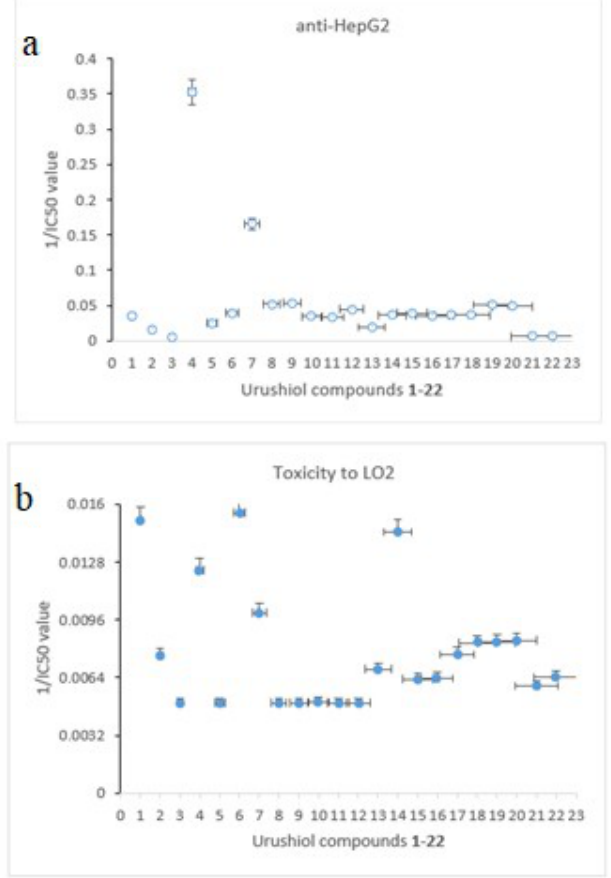
Figure 2. The relationship between compounds’ 1 – 22 anti-HepG2 or toxicity to LO2 and 1/IC50 value ( p < 0.05) (details are in the supplementary materials). ( a ) Relationship between compounds 1 – 22 and the anti-HepG2 1/IC50 value, and ( b ) relationship between compounds 1 – 22 and toxicity to LO2 1/IC50 value.